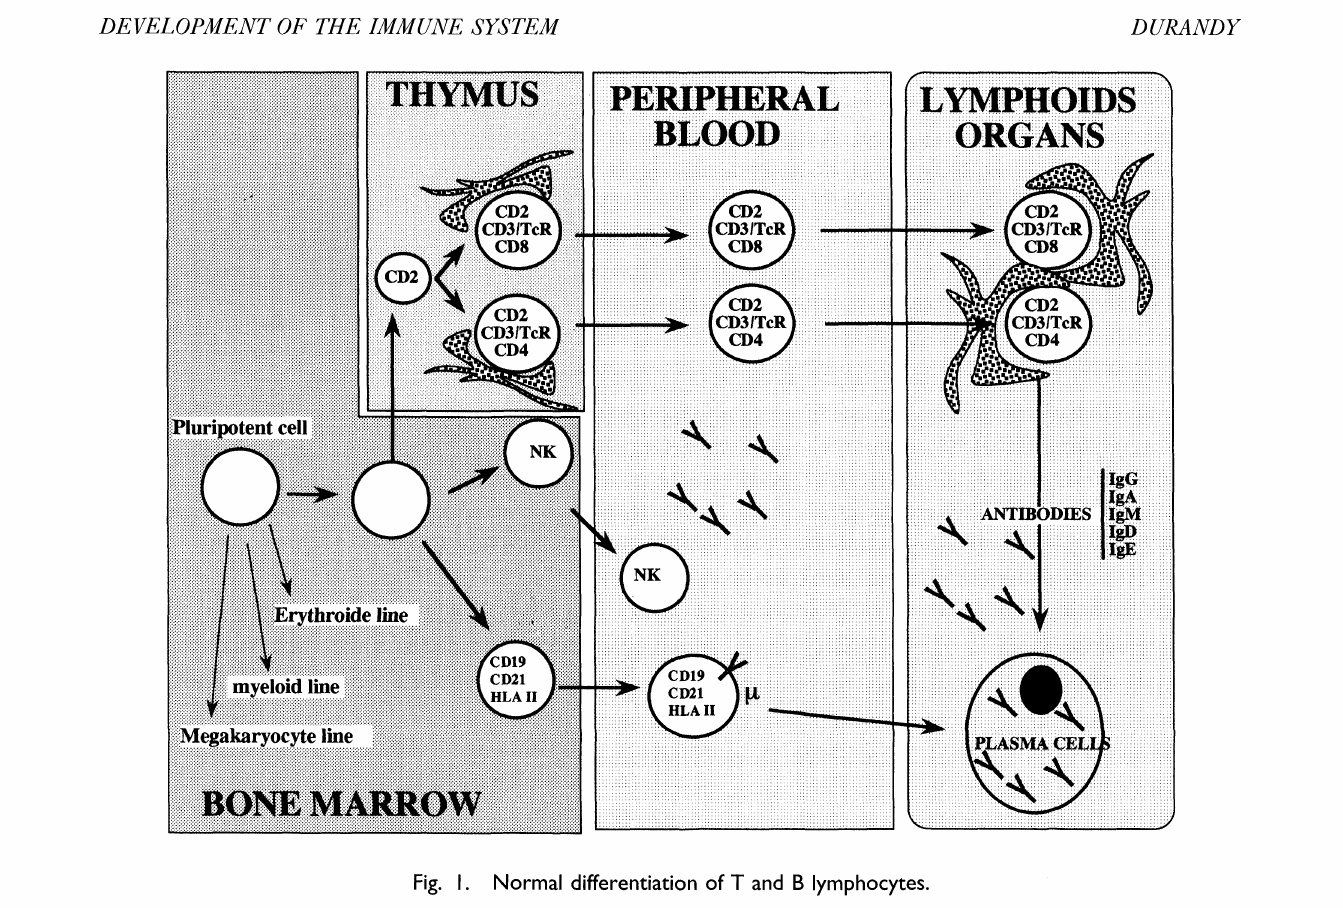
Fig. I. Normal differentiation of T and B